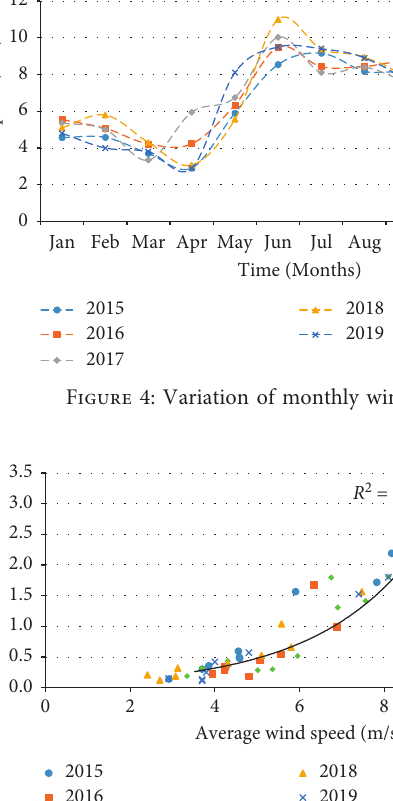
Figure 5: Variation of wind power generation versus average wind